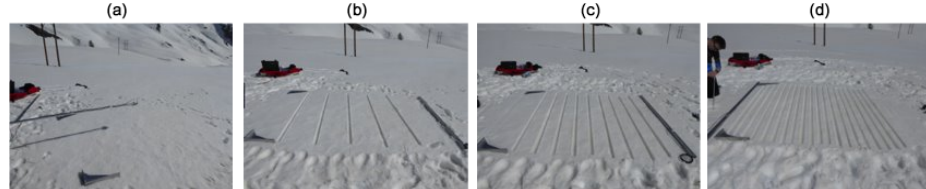
Figure 2. Studied surfaces of experiment A (Table 1), from (a) to (d) : A smooth, A η 7%, A η 13% and A η 27% sites.